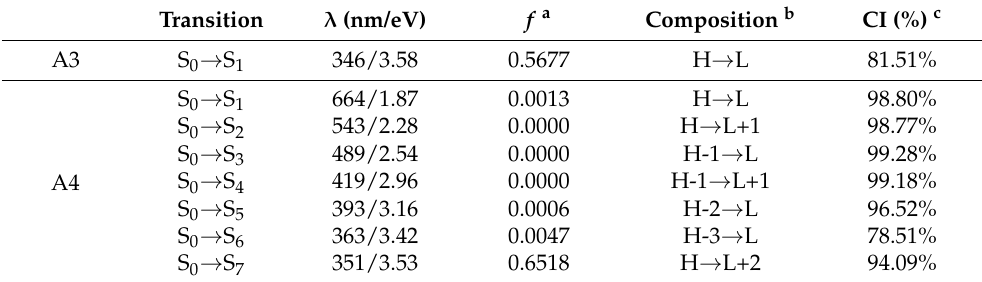
Table 1. B3LYP-D3/TZVP/IEFPCM levels calculated electronic excitation energies (nm), correspond- ing oscillator intensities and corresponding compositions for the A3 and A4 compounds.